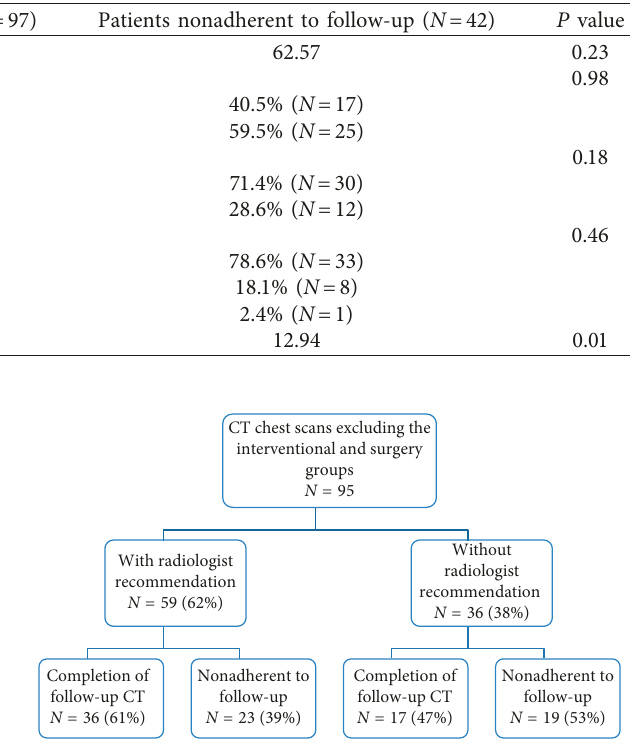
Figure 2: Analysis of follow-up in CTchest reports with vs. without an explicit imaging follow-up time interval recommendation by the interpreting radiologist. The rates of imaging follow-up were compared between the two groups, and this difference was not significant ( P � 0 .